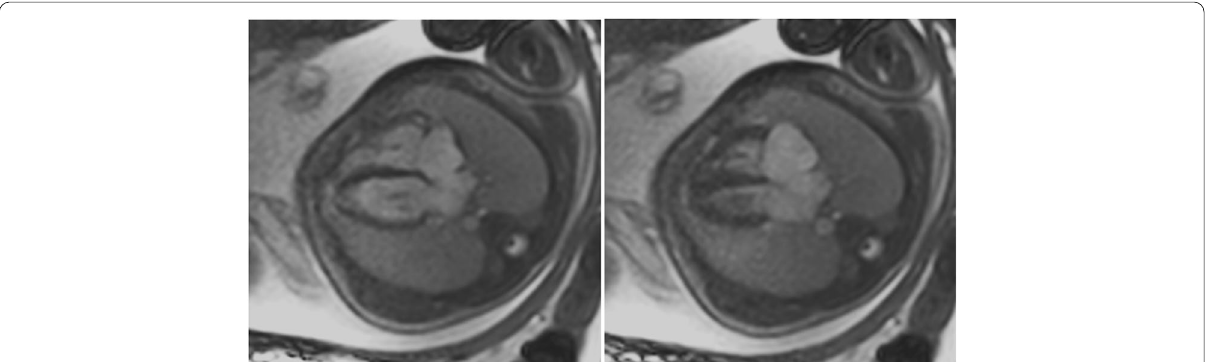
Fig. 19 (Four-chamber view in a late gestational healthy fetus): illustrating diastolic (left) and systolic (right) phases using Doppler ultrasound gated cardiac MRI. Ovale foramen as the physiological atrial shunt in the prenatal period is visualized in both diastolic and systolic phases. Motion artifacts (due to missing ECG triggering) normally blur cardiac contours in standard fetal MRI images